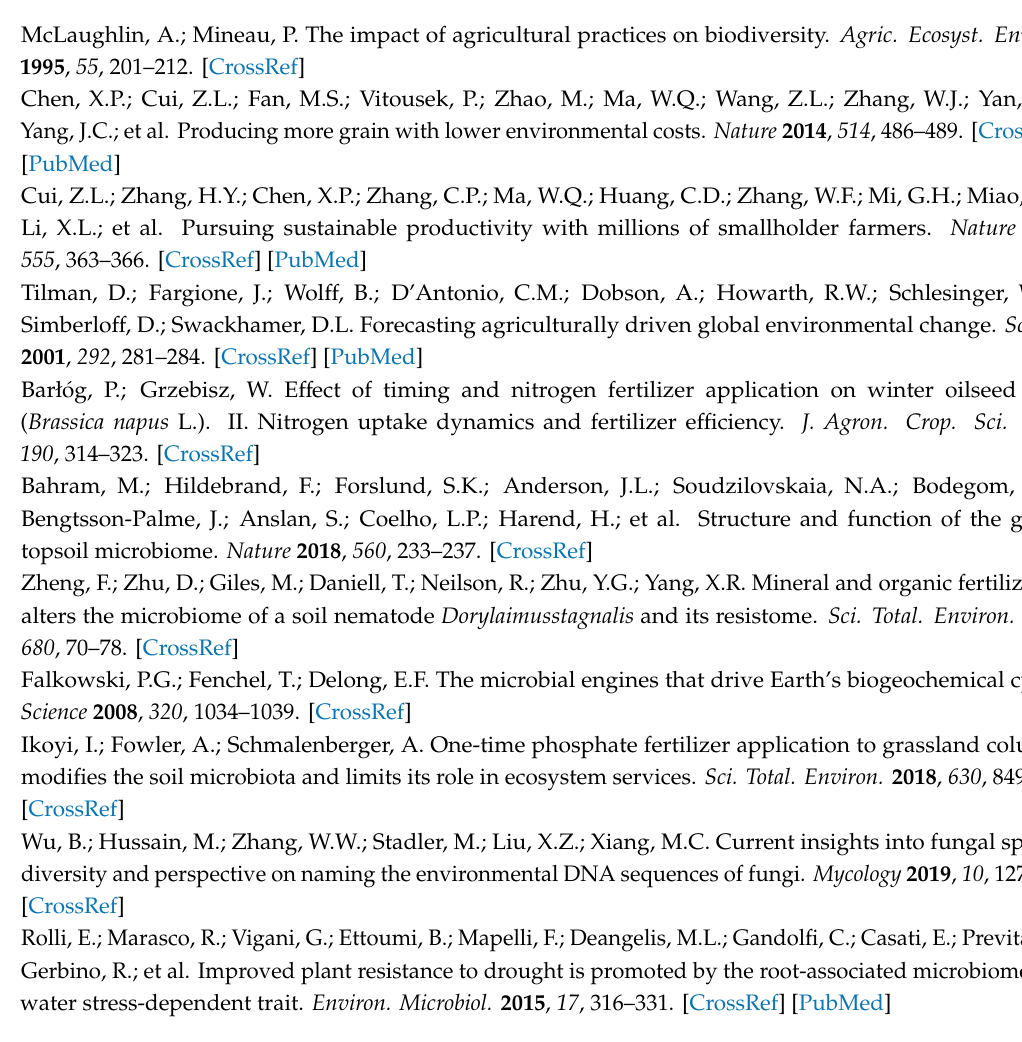
Figure S1: The samples collection approach used for collecting walnut tree bulk soil, rhizosphere, and fine roots. Figure S2: Root structure of walnut under stereomicroscope (fleshy and without root hairs). Table S1: Standard of soil nutrient classification in China. Table S2: Summary of 16S and ITS reads in the rhizosphere and root endosphere (mean ± SE, n = 5). Table S3: The linear discriminant analysis (LDA) e ff ect size (LEfSe) analysis was performed to identify the indicator of bacterial taxa representing each group, and the values were significant ( p < 0.05) when the LDA score was more than 2. Table S4: The linear discriminant analysis (LDA) e ff ect size (LEfSe) analysis was performed to identify the indicator of fungal taxa representing each group, and the values were significant ( p < 0.05) when the LDA score was more than